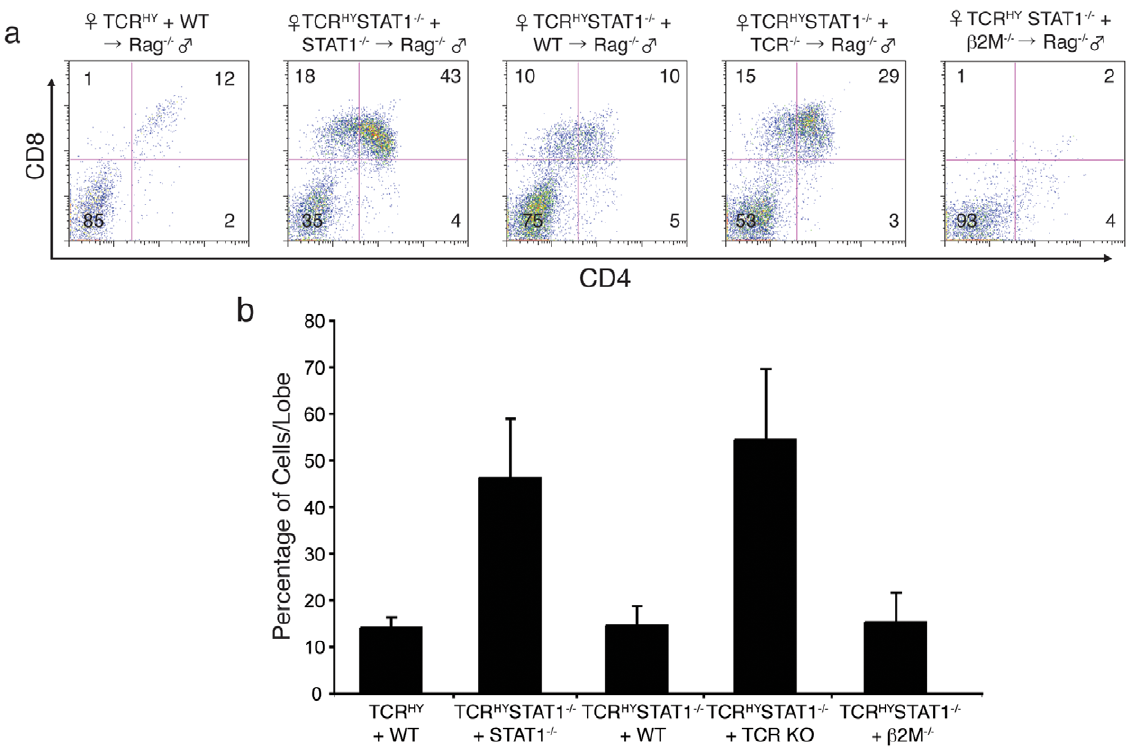
Figure 4. WT T cells promote deletion of autoreactive STAT1-deficient TCR HY thymocytes. ( a ) Flow-cytometry of thymic T cell subsets of chimeric mice. Thymocytes from the indicated BM chimeras were gated on TCR HY cells, and analyzed for CD4- and CD8-expressing subpopulations. The percentages of T cell subpopulations are indicated. ( b ) Graph represents percentages of total TCR HY CD8 + T cells from the indicated BM chimeras (Average and SD of 4–6 mice each).